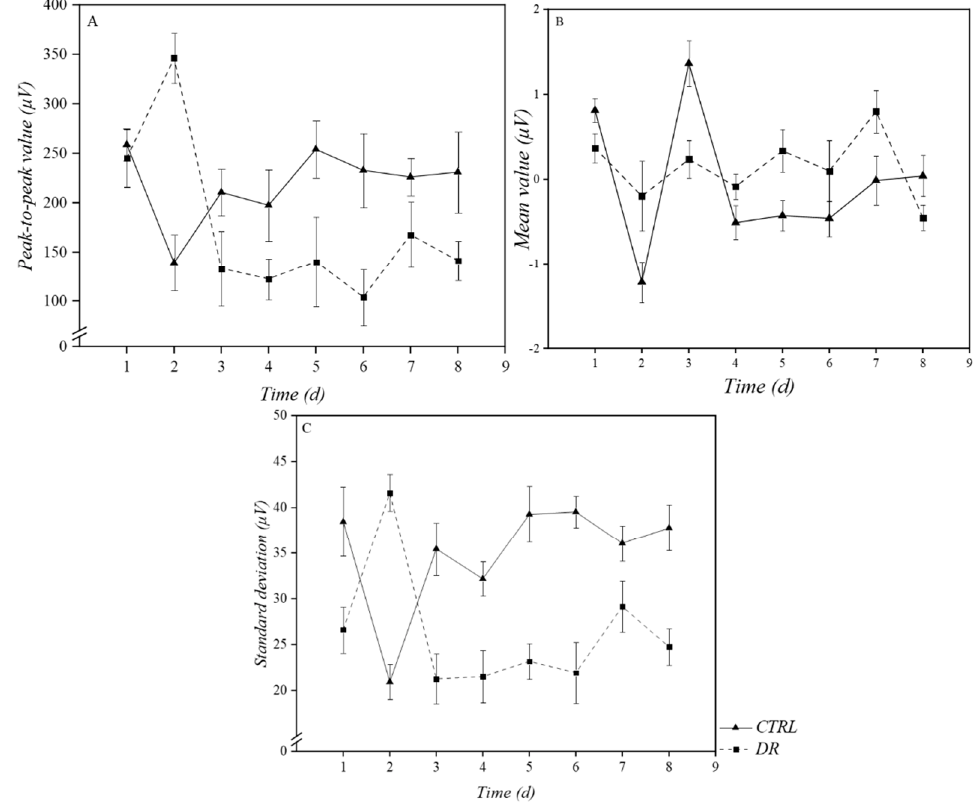
Figure 4. The change of time-domain parameters during the experiment (Day 1–Day 8). ( A ) is the change of peak-to-peak value; ( B ) is the change of mean value; and ( C ) is the change of standard deviation; i.e., control (CTRL), drought (DR). Table 1. The statistics of significant differences of each parameter between the drought treatment and the control treatment during the experiment (Day 1–Day 8).